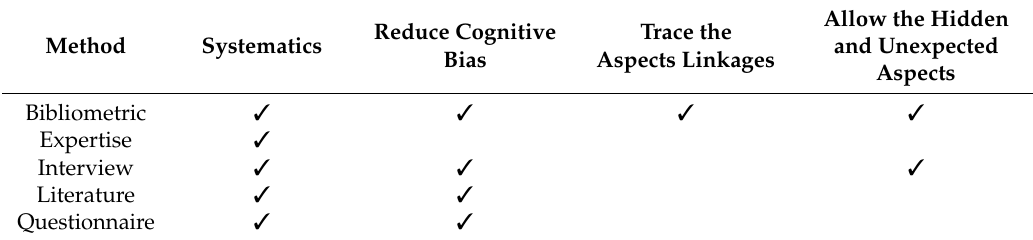
Table 2. Comparison of method approach.